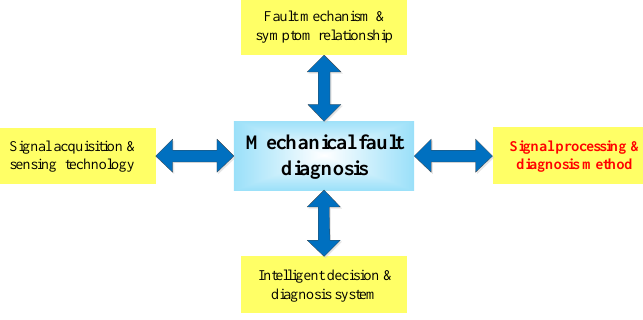
Figure 1. Research directions of mechanical fault diagnosis.